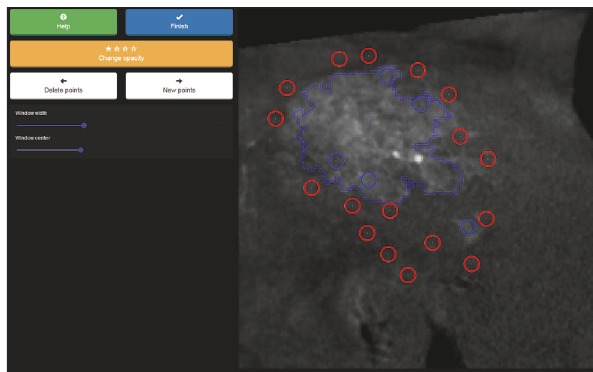
Figure 4: Joint segmentation prototype user interface. The user toggles the labels of prepositioned seed points, of which positions are displayed to them as colored circles, to properly indicate their inclusion into the set of object or background representatives. New seeds can be added at the position of current interaction via a long-press on the overlay image. The segmentation result and the displayed contour line adapt accordingly after each interaction.